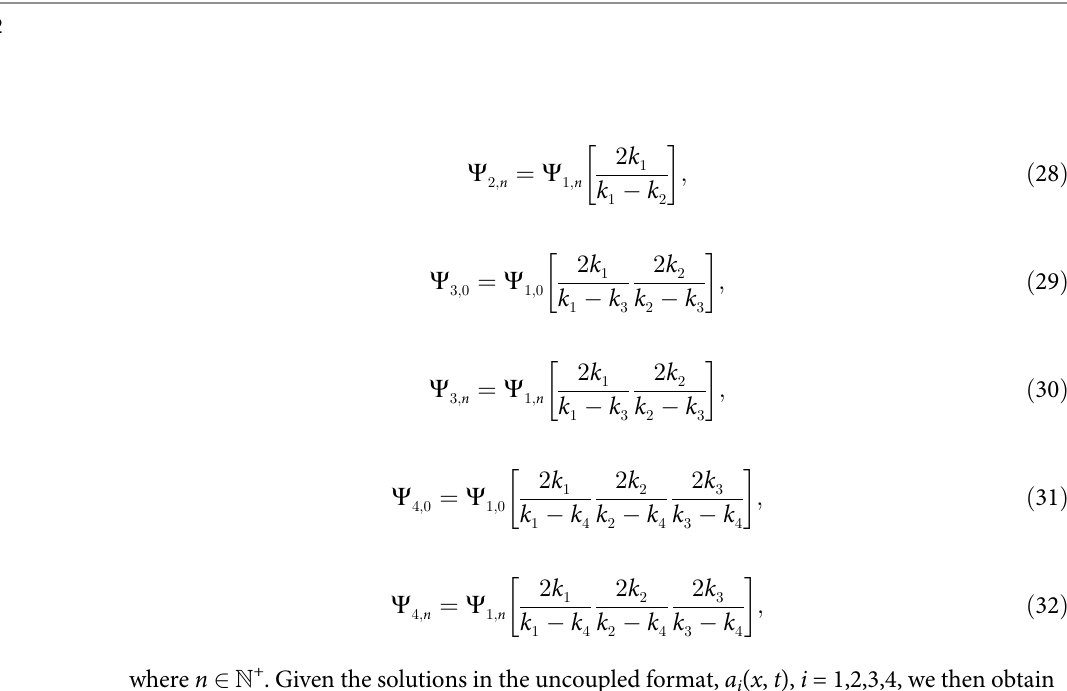
Fig 2. Comparison of exact and numerical solutions of Eqs (12) – (15) with distinct reaction rates where colonization fails to occur by t = 20. Profiles in (a) – (e), (f) – (j) and (k) – (o) show C 1 ( x , t ), C 2 ( x , t ), C 3 ( x , t ), C 4 ( x , t ) and S ( x , t ) at t = 0,10, and 20, respectively. Each subfigure shows the exact solution (solid red) superimposed on the numerical solution (dashed blue). This example corresponds to exponential domain growth with L (0) = 1, L (10) = e (cid:5) 2.78 and L (20) = e 2 (cid:5) 7.39, as indicated in each subfigure. The exact solutions are obtained by truncating the infinite series after 1000 terms and the numerical solutions (S1 Supporting Information) correspond to δξ = δ t = 1 × 10 − 3 . Other parameters are L (0) = 1, α = 0.1, C = 1, γ = 0.2, D = 1 × 10 − 5 , k 1 = 0.1, k 2 = 0.2, k 3 = 0.3 and k 4 =